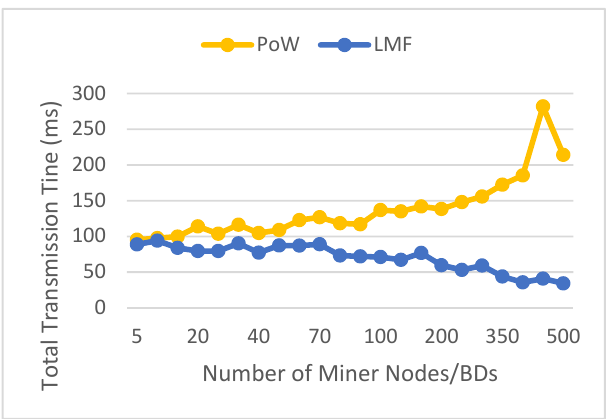
Figure 17. The total transmission time vs. the number of miners/BDs on the PoW and LMF models.